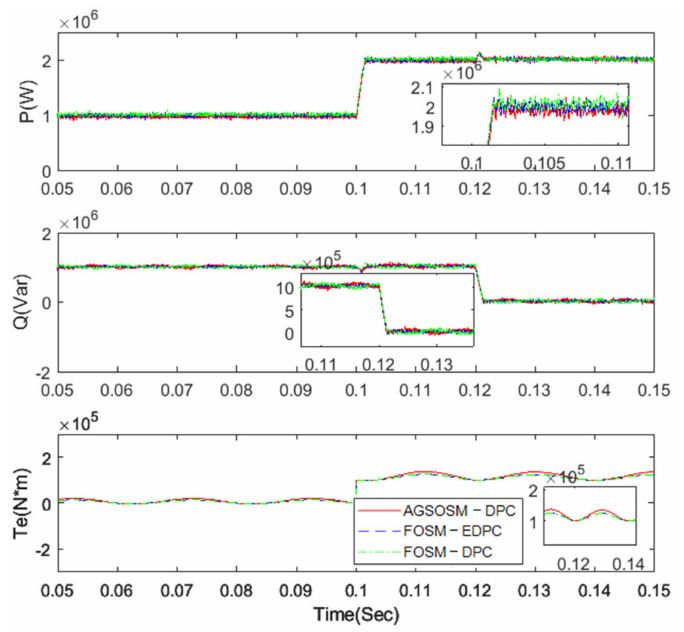
Figure 3. Active power, reactive power, and electromagnetic torque under balanced grid voltage.